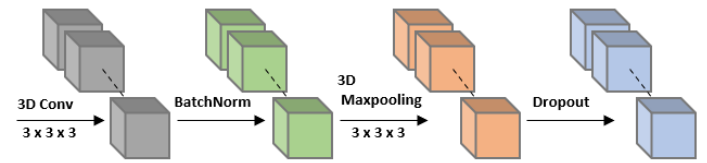
Figure 3. Layers of each Conv block.